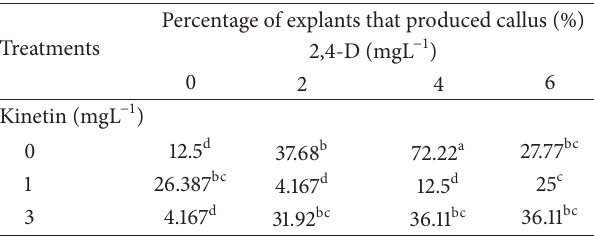
Table 2: Effects of the combination 2,4-D and kinetin at different concentrations on the percentage of callus induction from petiole explants.